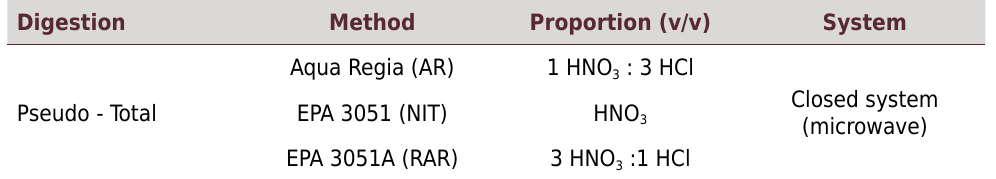
Table 2. Description of the digestion methods